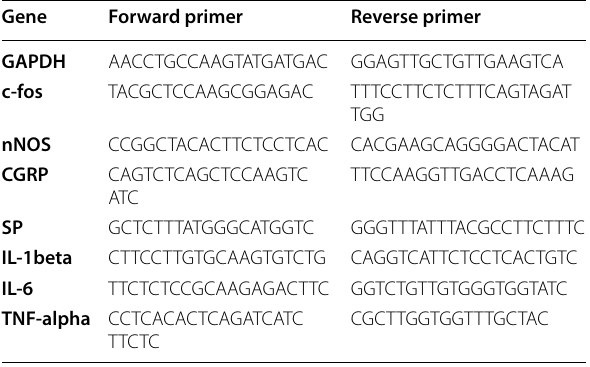
Table 2 Primer sequences obtained from the AutoPrime software (http:// www. autop rime. de/ AutoP rimeW eb) and